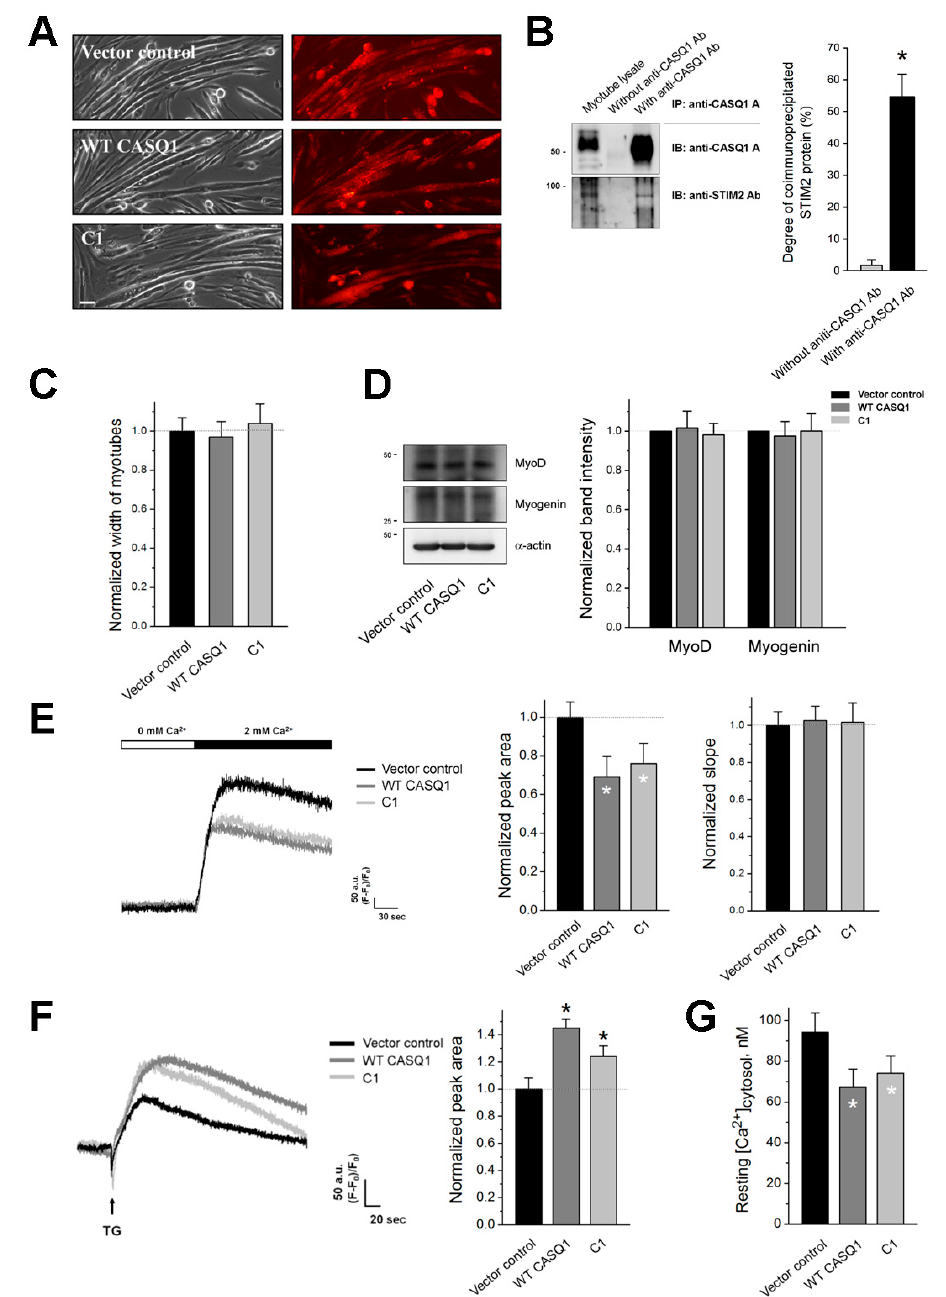
Figure 2. SOCE, Ca 2+ amount in the SR, and cytosolic Ca 2+ level in WT CASQ1 or C1-expressing mouse skeletal myotubes: ( A ) Mouse primary skeletal myotubes that were transfected with cDNA of empty vector (vector control), full-length wild-type CASQ1 (WT CASQ1), or C1 region (C1) were subjected to immunocytochemistry using anti-GFP antibodies. The bar represents 100 μ m. ( B ) The lysate of WT CASQ1 or C1-expressing myotubes was subjected to a coimmunoprecipitation assay with anti-CASQ1 antibody, and the immunoprecipitate was subjected to immunoblot analysis with anti-CASQ1 or anti-STIM2 antibody. ‘Myotube lysate’ indicates a simple immunoblot of the myotube lysate. ‘Without anti-CASQ1 Ab’ indicates a reaction without an anti-CASQ1 antibody. Three independent experiments were conducted, and a representative result is presented. The degree of coimmunoprecipitated STIM2 to total STIM2 is presented as histograms. STIM2 was successfully coimmunoprecipitated with CASQ1. IB, IP, or Ab indicates immunoblot, immunoprecipitation, or antibody, respectively. *Significant difference was compared with ‘without anti-CASQ1 Ab’ ( p < 0.05). ( C ) Myotube widths were measured. The normalized mean values of each to the mean value of the vector control are summarized as histograms. There was no significant difference in the width of the myotubes. ( D ) The myotube lysate was subjected to immunoblot assays with antibodies against MyoD or myogenin. α -actin was used as a loading control. Three independent experiments